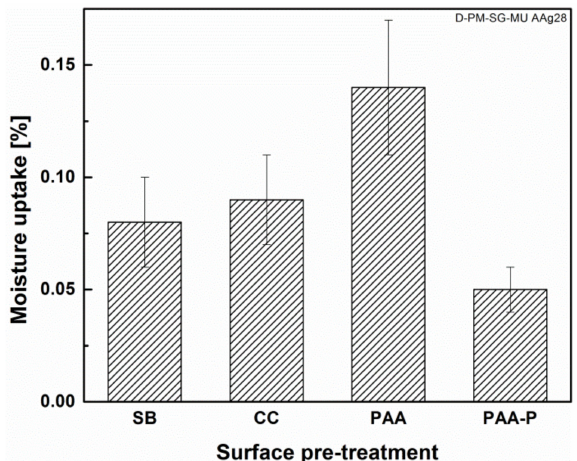
Figure 8. Moisture uptake of the FSp joints after 28 days of accelerated